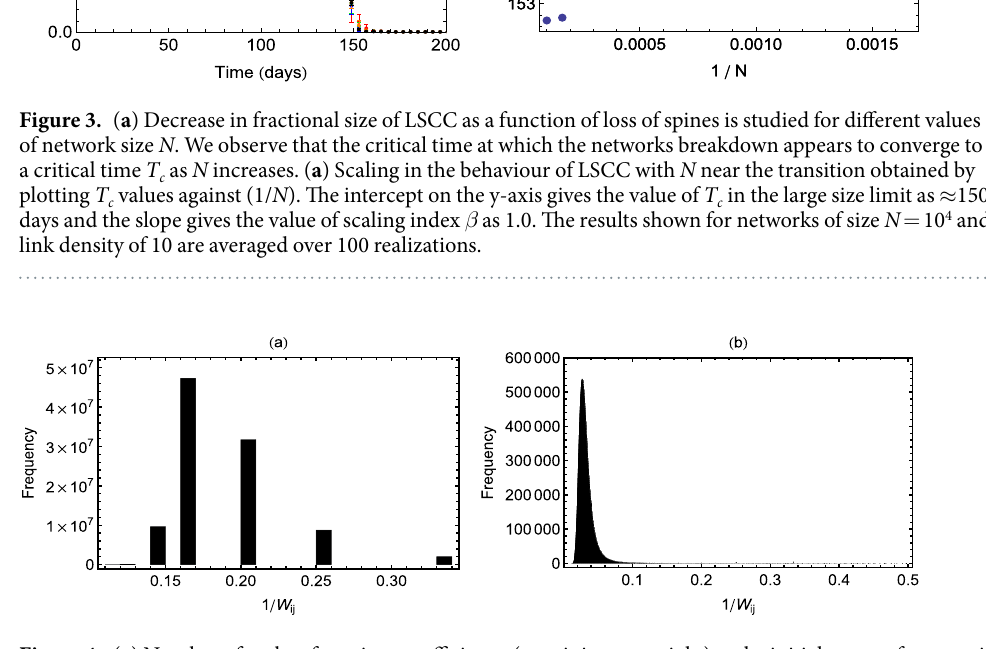
Figure 4. ( a ) Number of paths of maximum-efficiency (or minimum-weight) at the initial stages of connections in the network. In the initial stage, the network has ≈ 10 7 directed paths with efficiency in the range 0.2–0.3. ( b ) Final stages of decay after 120 days. With the progressive loss of links, the total number of paths as well as the average efficiency of individual paths